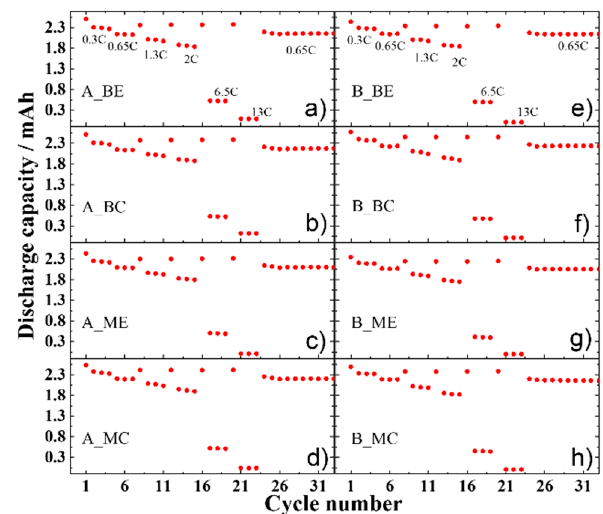
Figure 7. Rate capability test of cathodes harvested from aged cell A ( a – d ) and cell B ( e – h ) (1C = 2.3 mA ∙ cm − 2 ). The detailed test protocol is reported in Table S2 in the Supplementary Materials.